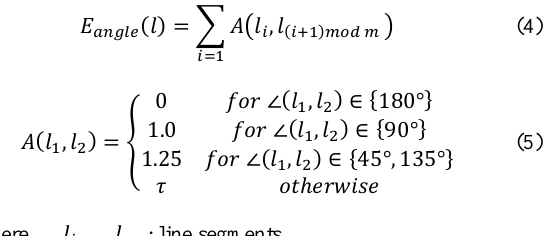
Figure 5. Example of a search space (red points) for four observations (blue points).